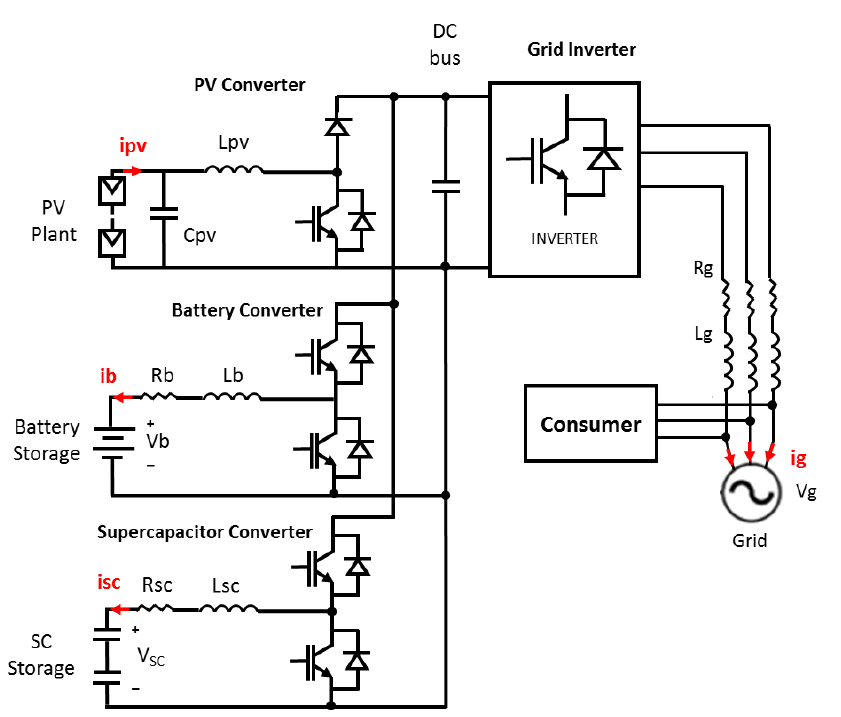
Figure 18. Scheme of model studied adapted from [78].